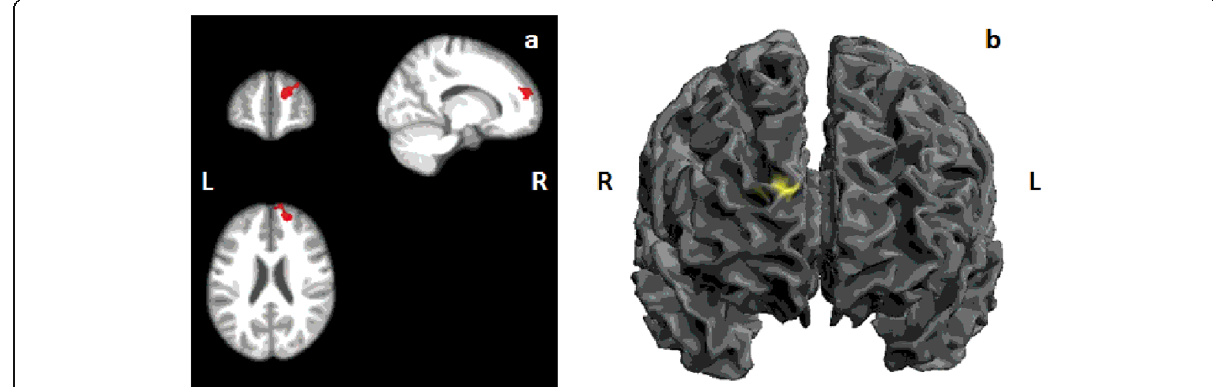
Fig. 1 Cluster results showing region of reduced GMV in the right dorsal medial prefrontal cortex. The results are from a t-test of EM patients without prior clinical care compared to those with prior clinical care. A displays the cluster on the average brain created from all 117 patients. Cluster forming threshold of p =0.001, k=418, pFWE<0.05 at cluster-level. B displays the cluster on the SPM12 cortical surface. L: left; R: